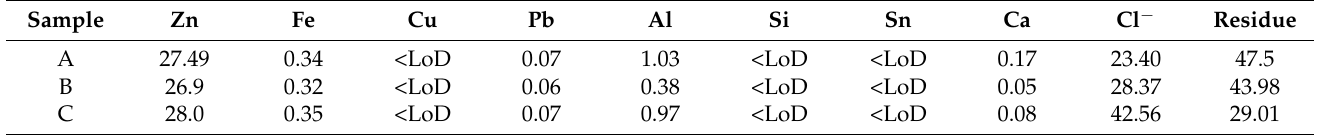
Table 2. Content (%) of elements in samples, LoD—limit of detection in AAS